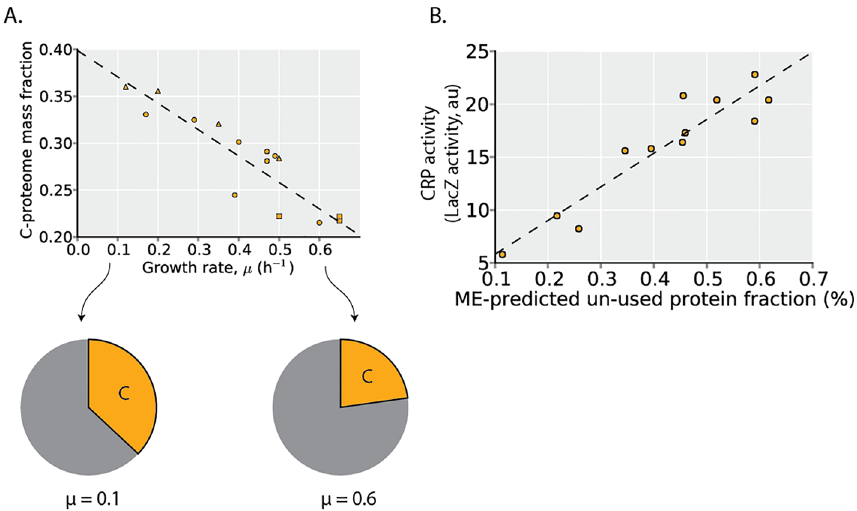
Fig 6. The non-core proteome is largely unutilized in a given environment. (A) The proteome mass fraction of the C-proteome is plotted as a function of growth rate in the profiled environments (which predominantly comprise carbon source shifts and carbon limitation). The dashed line is a linear regression (y = -0.28 x + 0.40, r 2 = 0.81, p < 10 − 4 ). Point shape indicates environment type (carbon source batch cultures = circles, glucose-limited chemostat cultures = triangles, stress conditions = squares). The allocation to the C-proteome at different growth rates is shown in the pie charts based on the regression. ( B ) As the fraction of the proteome that is non-core and utilized remains relatively constant, the induction of non-core proteome segments by transcriptional regulators is expected to result in an increase in un-utilized protein. Using the ME-Model, the maximum un-used protein fraction under different carbon sources is computed based on measured growth rates from You et al. [23]. Measured Crp activity under different carbon sources from You et al. [23] is compared to the model-predicted un-used proteome fraction. The data is consistent with the hypothesis that Crp induces the expression of un-used